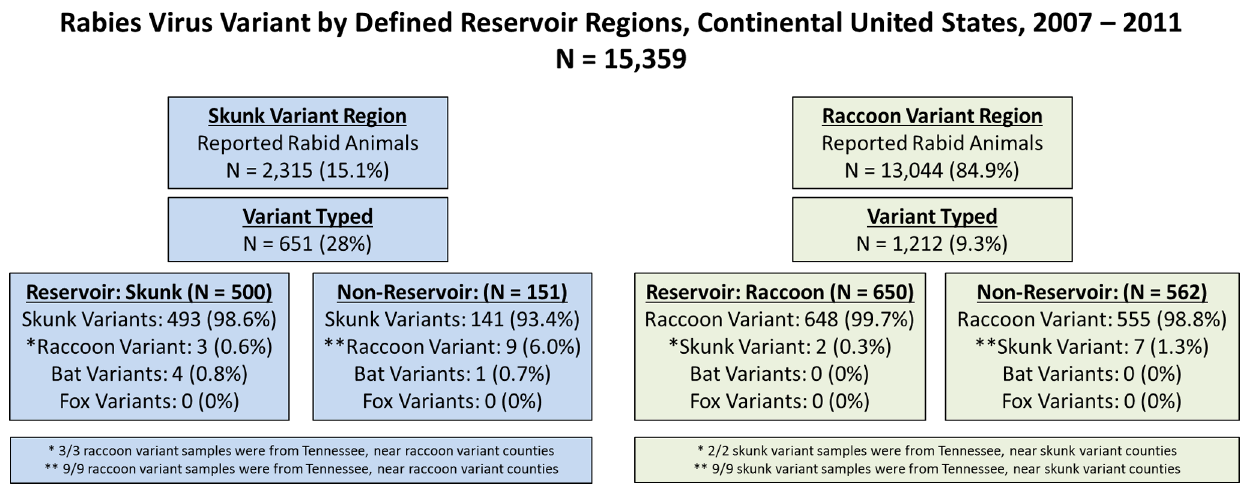
Figure 6. Comparison of Confirmed Rabies Virus Variant and Predicted Rabies Virus Variant, 2007–2011.